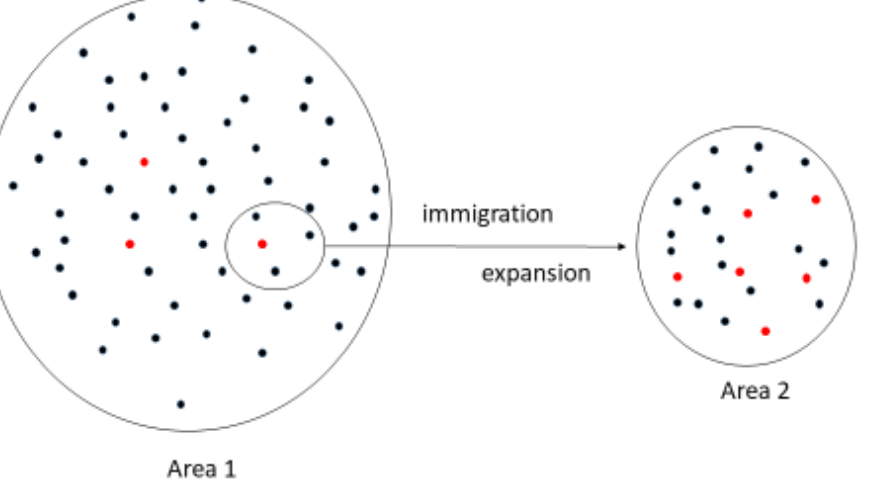
Figure 2. Founder effects. A small number of individuals, including one with URAT1 mutation (red circle), immigrated to a new area and expanded. As the population expanded in the new area, the number of individuals with the URAT1 mutation increased.